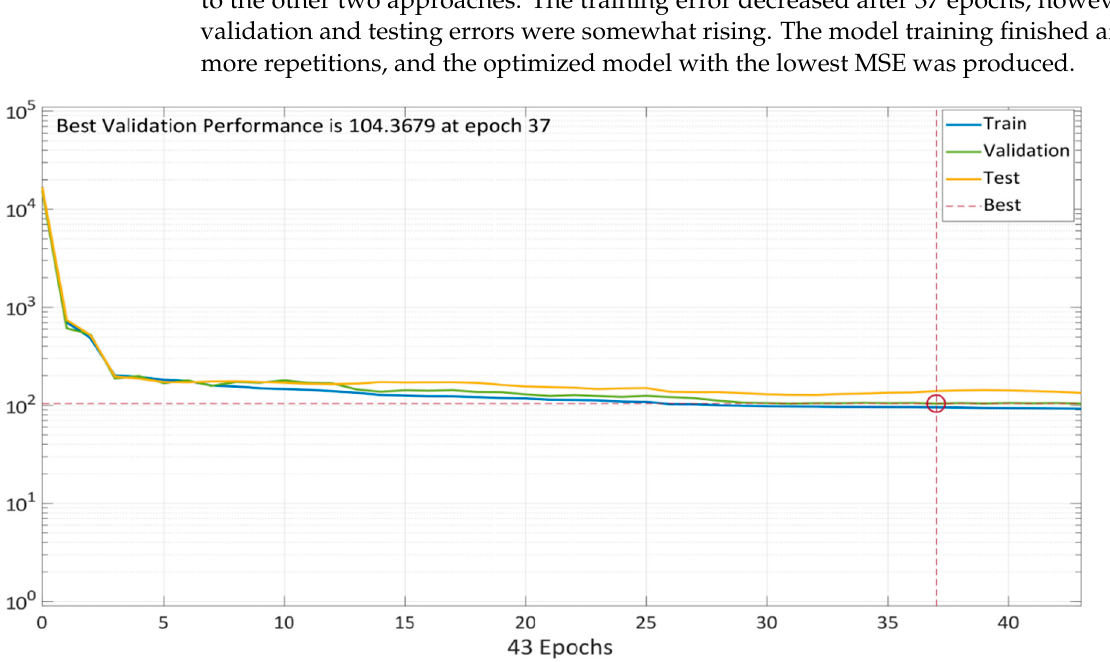
( b ) Figure 17. Training State of SCG Algorithm: ( a ) Gradient graph at epoch 43; ( b ) Validation checks graph at epoch 43. For training, validation, and testing, Figure 18 shows the model error histogram. The graph demonstrates how inaccurately the error bar bins seem to converge to the zero- error line. These results conclude that the model has high error values in comparison to